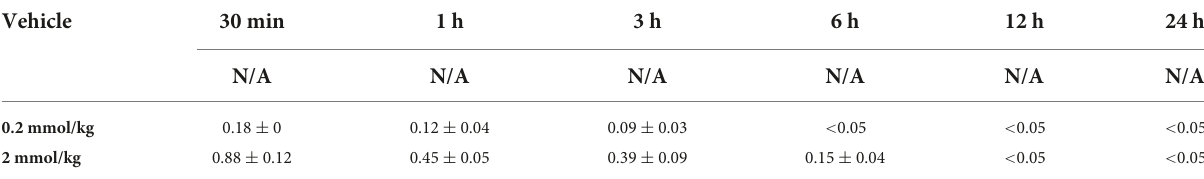
TABLE 1 Serum lithium concentrations measured by ICP-MS and shown in